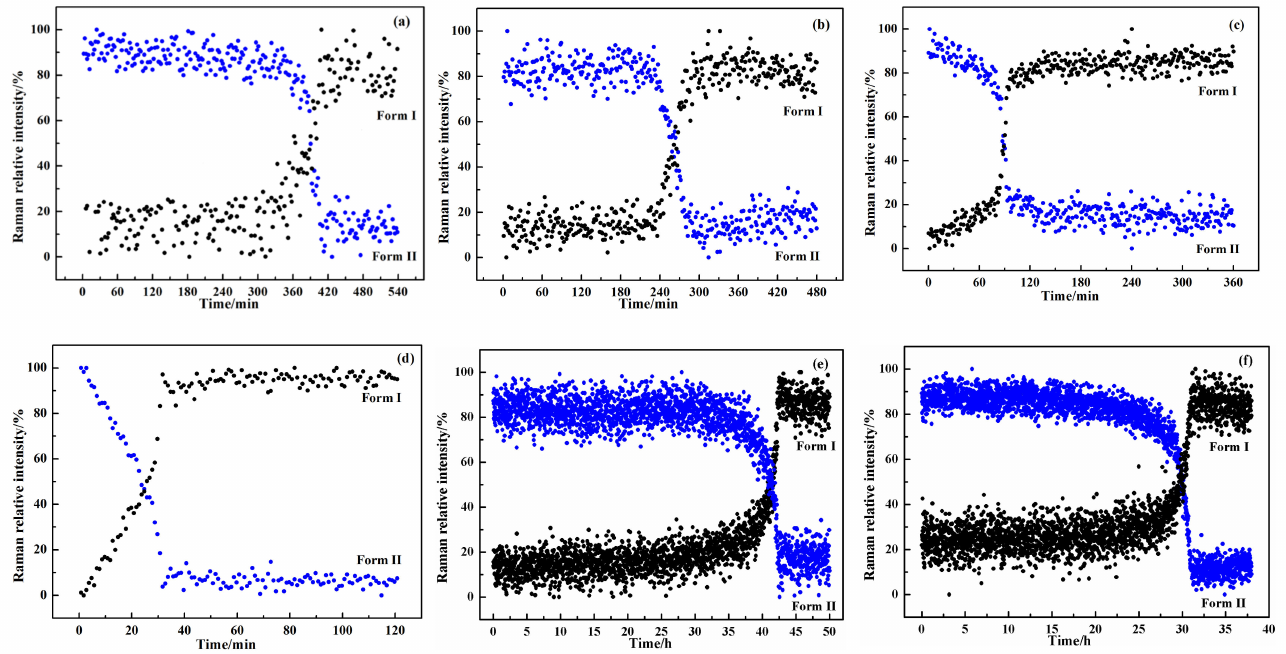
Figure 8. Changes of Raman relative intensity during the solution-mediated polymorphic transfor- mation of L-carnosine in different binary solvent mixtures: ( a ) water + methanol; ( b ) water + ethanol; ( c ) water + 2-propanol; ( d ) water + acetone; ( e ) water + DMF; ( f ) water +